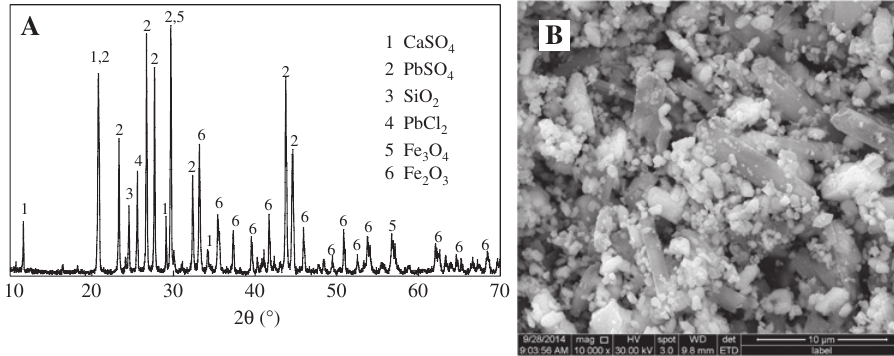
Figure 11: X-ray diffraction pattern (A) and scanning electron microscope image (B) of leached WLR-SD.